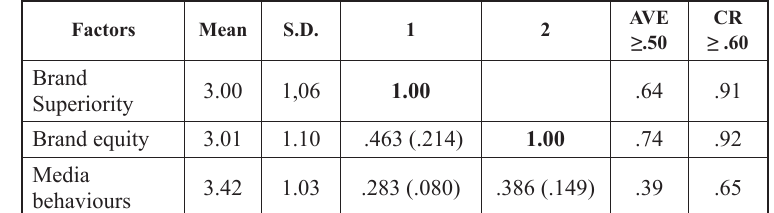
Table 3. Structural equation modelling results